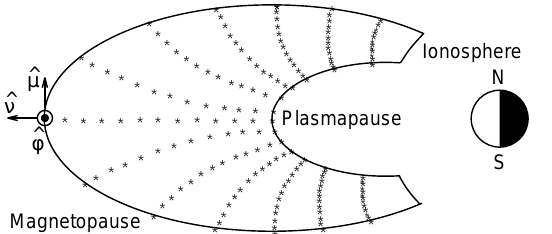
Fig. 6. Boundaries and shape of the dipole model with the dipole coordinate system: ^ (cid:108) points parallel to the dipole field, ^ (cid:109) radially outward and ^ (cid:47) perpendicular to both in azimuthal direction